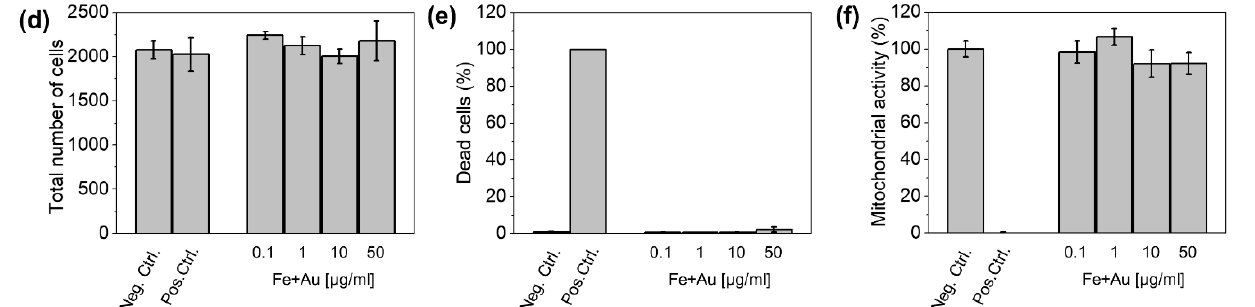
Figure 4. Representative optical microscopy images of HFF ‐ 1 cells incubated with Au@Fe ‐ PEG NPs: ( a ) negative control, ( b ) positive control, ( c ) cells incubated with 50 μ g/mL Fe + Au. Images show a merge of brightfield (gray), Hoechst 33342 (blue), and PI (red). Scale bars correspond to 100 μ m. Quantification of total number of cells per well, ( d ) percentage of dead cells, ( e ) mitochondrial activity ( f ) of cells exposed to increasing concentration of Au@Fe ‐ PEG NPs.